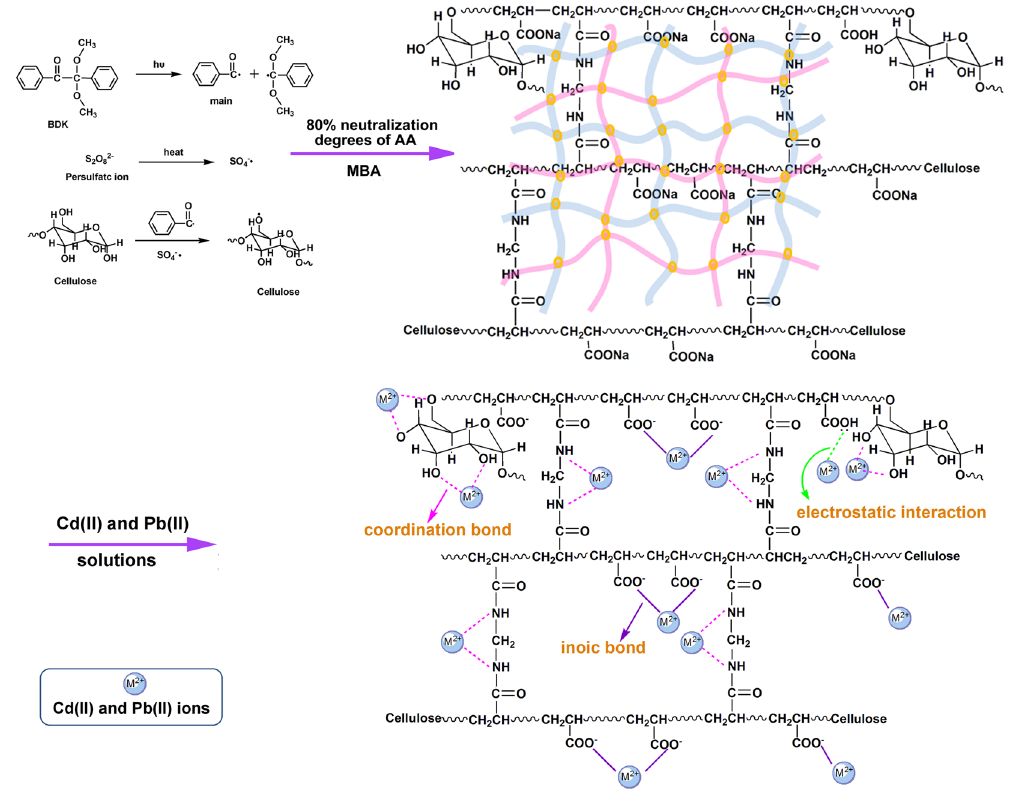
Figure 1. Schematic diagram of SR–PAA synthesis and adsorption of Cd(II) and Pb(II) ions on the